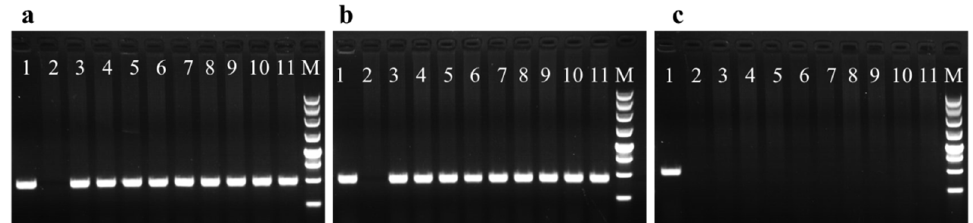
Figure 3. PCR analysis of hygromycin-resistant lines P1 to P9 transformed by Agrobacterium tumefaciens GV3101. ( a ) PCR amplification with primers for HPT (480 bp). ( b ) PCR amplification with primers for GUS (450 bp). ( c ) PCR amplification with primers for virG (485 bp). Lane 1 positive control (GV3101 containing the plasmid pCAMBIA1301), Lane 2 negative control (Total DNA from non-transformed embryogenic tissue), Lanes 3–11 Total DNA from the nine different hygromycin-resistant lines P1 to P9, M 250-bp marker.